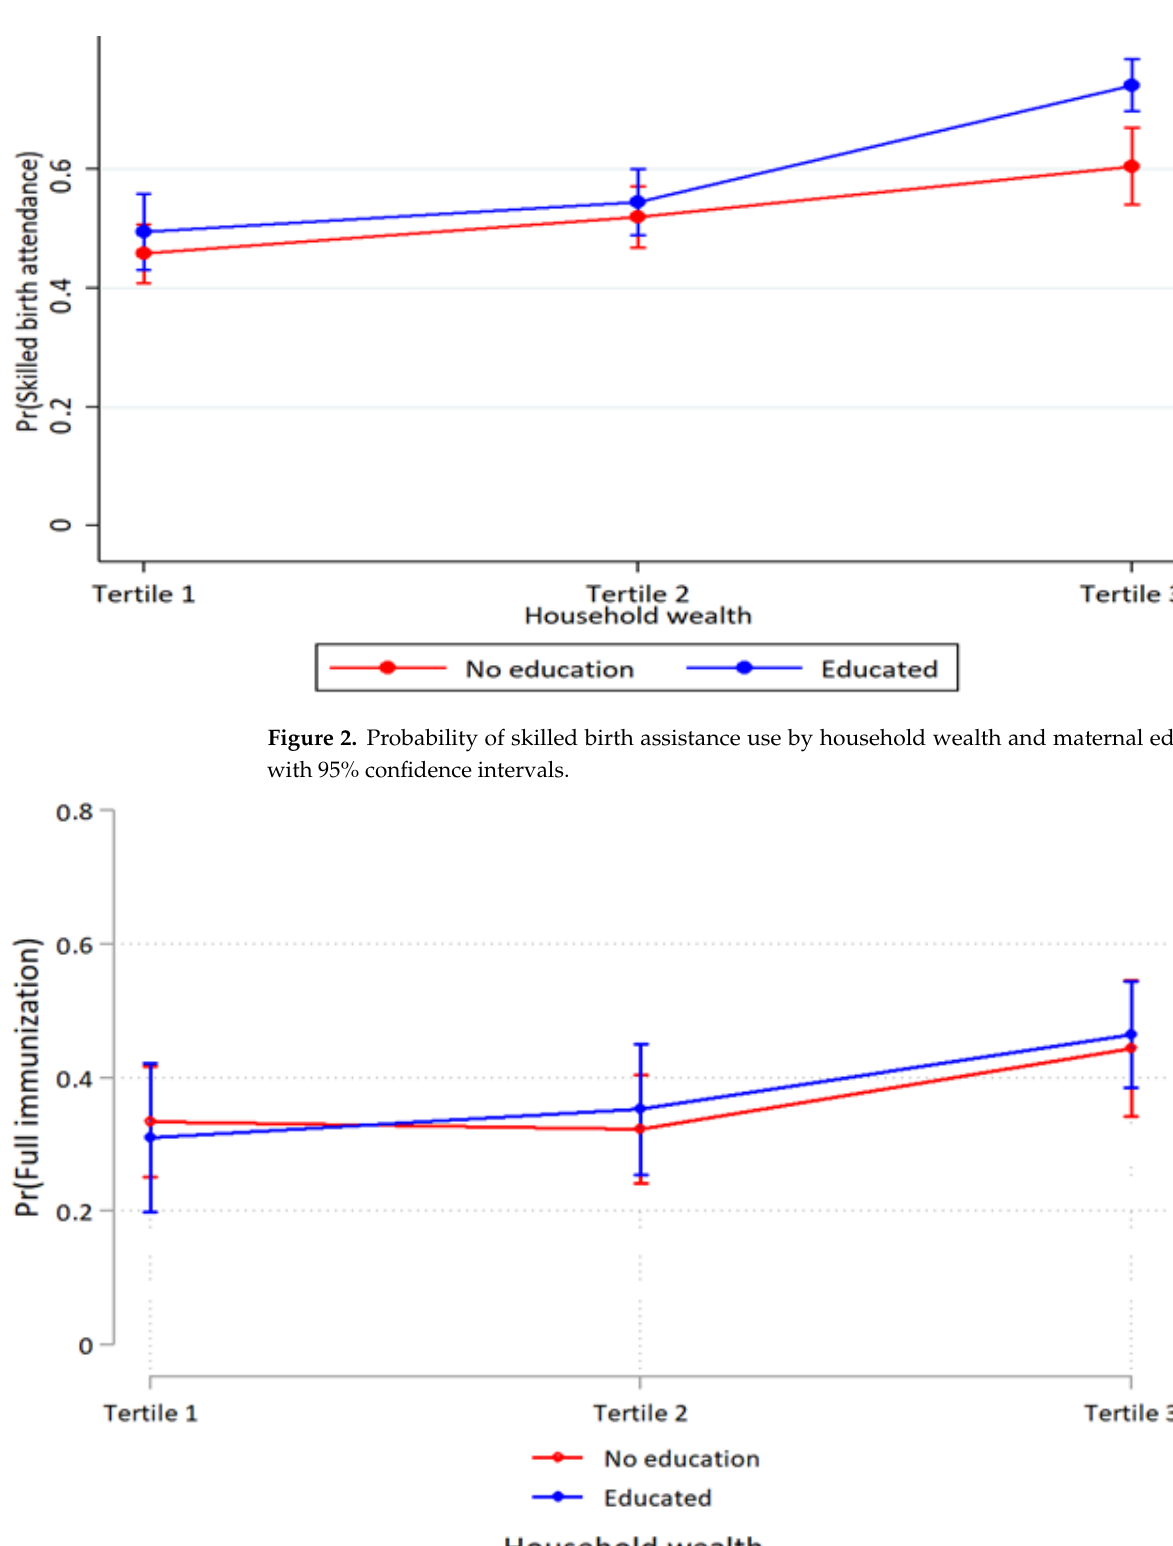
Figure 1. Probability of four or more antenatal care use by household wealth and maternal educa- tion with 95% confidence intervals.